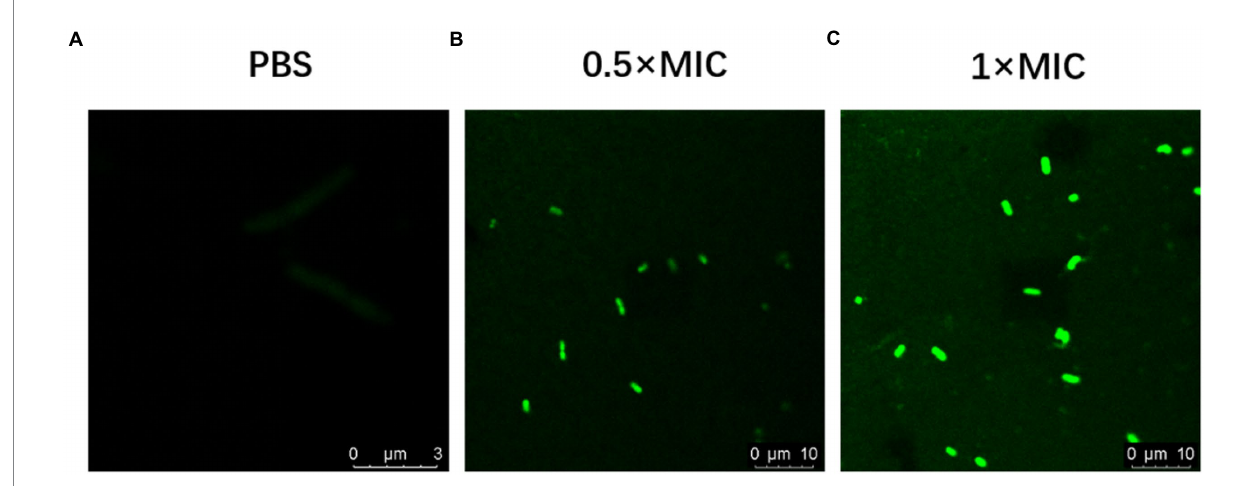
FIGURE 6 Confocal laser scanning micrograph of E. coli B2 treated with OM19r and FITC-OM19r. (A-C) Images obtained by fluorescence microscope.